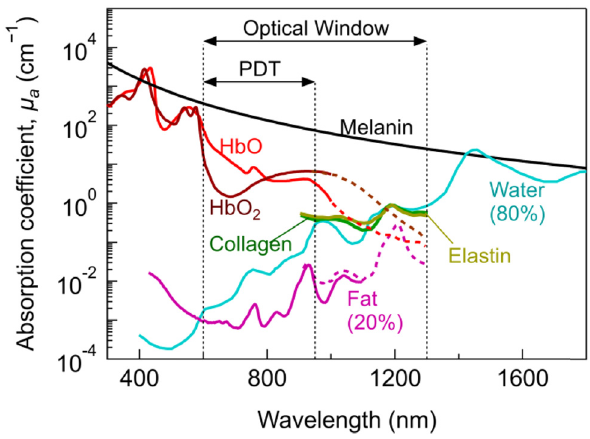
Figure 6: Absorption coe ffi cient as a function of wavelength for several tissue constituents. Reproduced from Algorri et al. [ 47 ] .